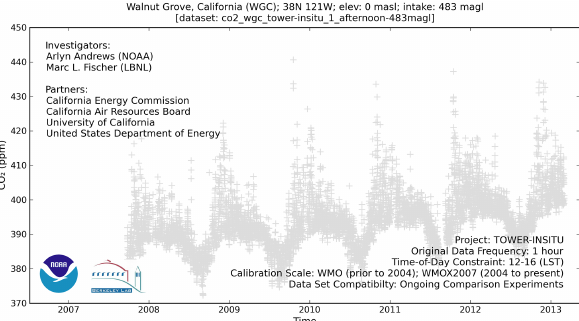
Figure 1. Graph constructed using data and metadata from a single ObsPack data